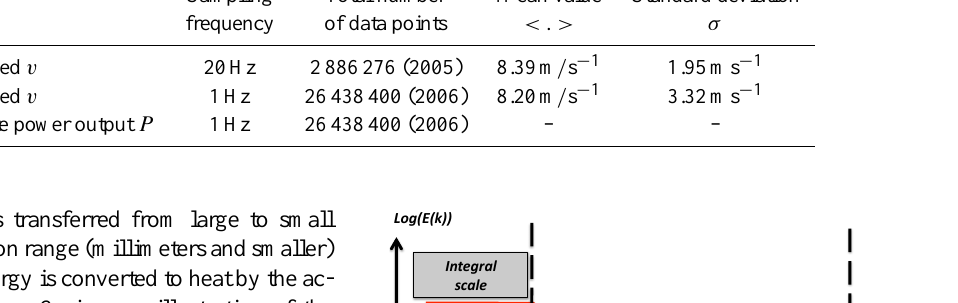
Table 1. Description of our database with the mean and the standard deviation values. Data set